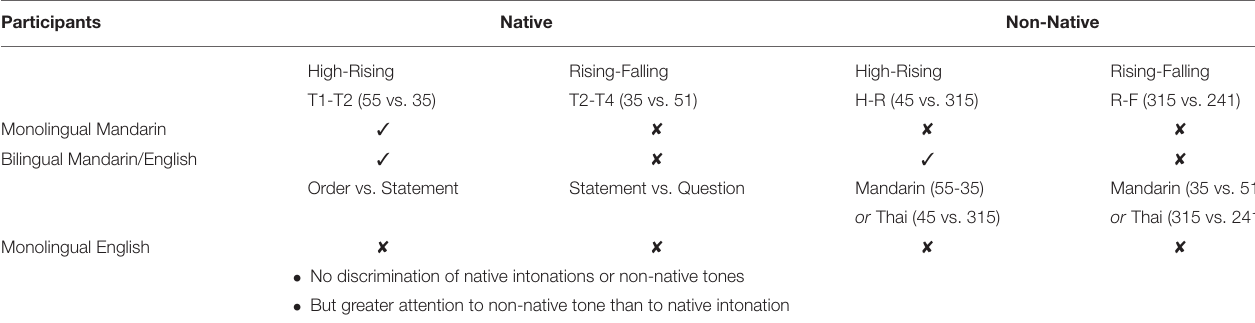
TABLE 3 | Summary of word learning results in the Three Experiments ( 3 = significant word learning, 8 = no significant word